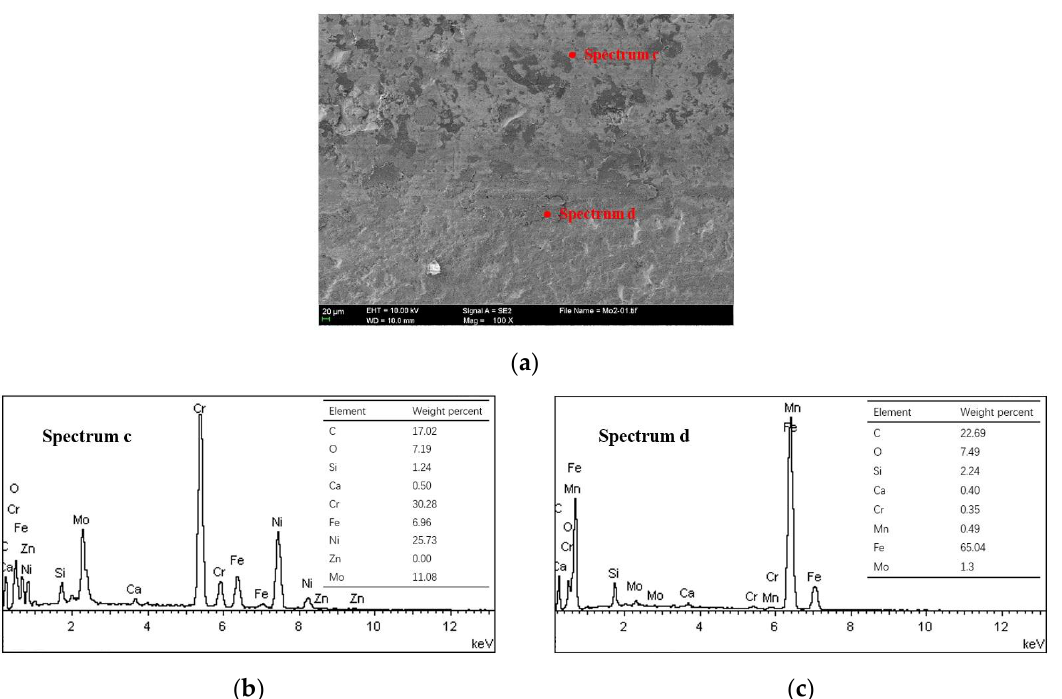
Figure 7. Scuffed piston ring surface and elemental content of NCM/Fe. ( a ) SEM image; ( b ) EDS spectrum c; ( c ) EDS spectrum d